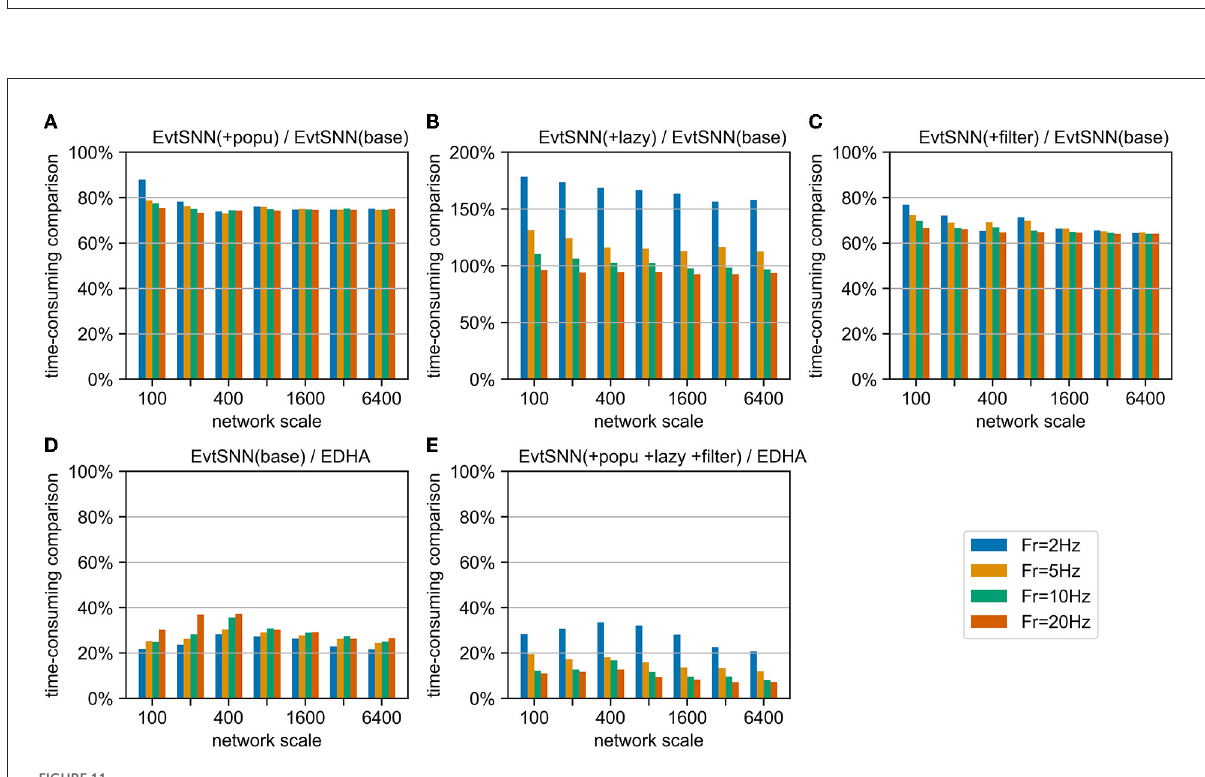
FIGURE11 Time-consuming comparison chart. (A–C) EvtSNN time-consuming reduction after enabling popu, lazy, and filter, respectively. (D,E) Time-consuming comparison of EvtSNN and EDHA with none/all optimizations.